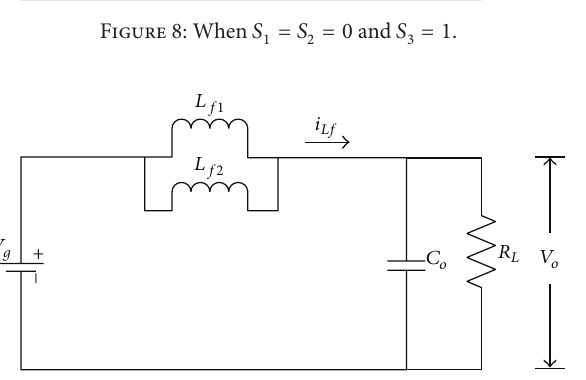
Figure 9: When 𝑆 1 = 𝑆 2 = 𝑆 3 = 1 .